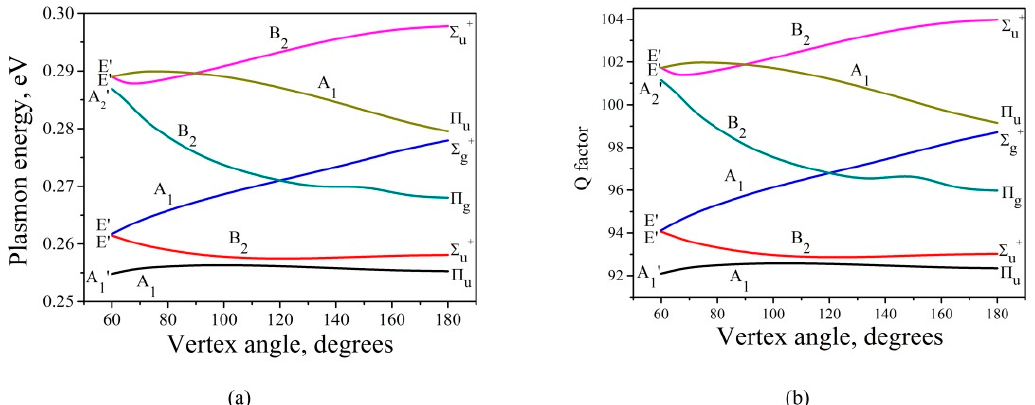
Figure 7. ( a ) Plasmonic energy diagram of graphene plasmonic trimers. ( b ) Corresponding quality factors of the plasmon modes as a function of vertex angle. The chemical potential of graphene is 0.6 eV. Compared with trimers of 0.5 eV graphene, the energy diagram shows blue shift, and the corresponding Q factors increase.